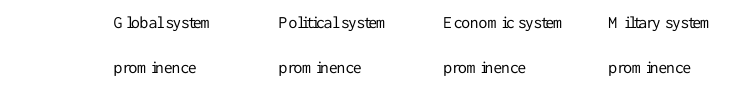
Table 2: Correlation Matrix for Prominence Indicators (pooled over all